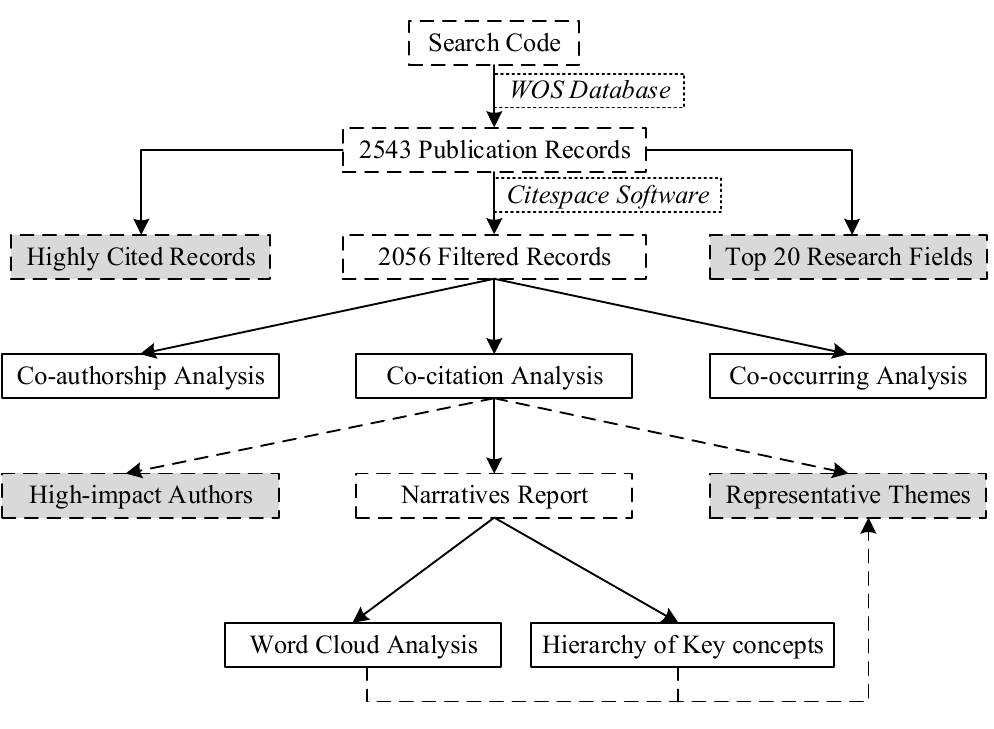
Figure 3. Research procedure of this study.